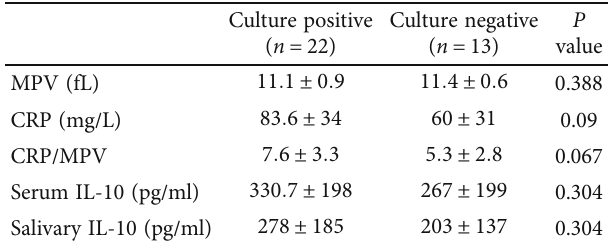
Table 2: Comparison of biomarkers for late-onset sepsis between blood culture positive and negative septic